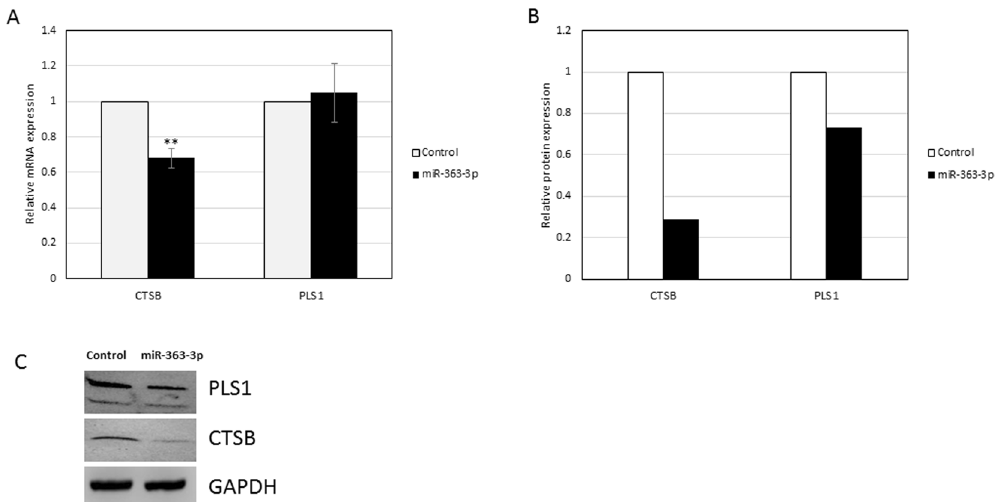
Figure 5. Effects of over-expression of miR-363-3p in HEY cells on the mRNA and protein expression of its predicted targets CTSB and PLS1. ( A ) Relative protein expression levels of CTSB and PLS1 as determined by Western blot. ( B ) Relative mRNA expression of CTSB and PLS1 as determined by qRT-PCR shows a significant decrease in CTSB mRNA levels but no significant changes on levels of PLS1. Expression values are normalized to negative control group and represent mean ± SD of at least three biological replicates each performed in three technical replicates. Asterisks represent statistically significant differences from the negative control group. ( ** p < 0.05) ( C ) Western blot analysis of CTSB and PLS1 proteins both display reduced levels of protein in the miR-363-3p group relative to negative control